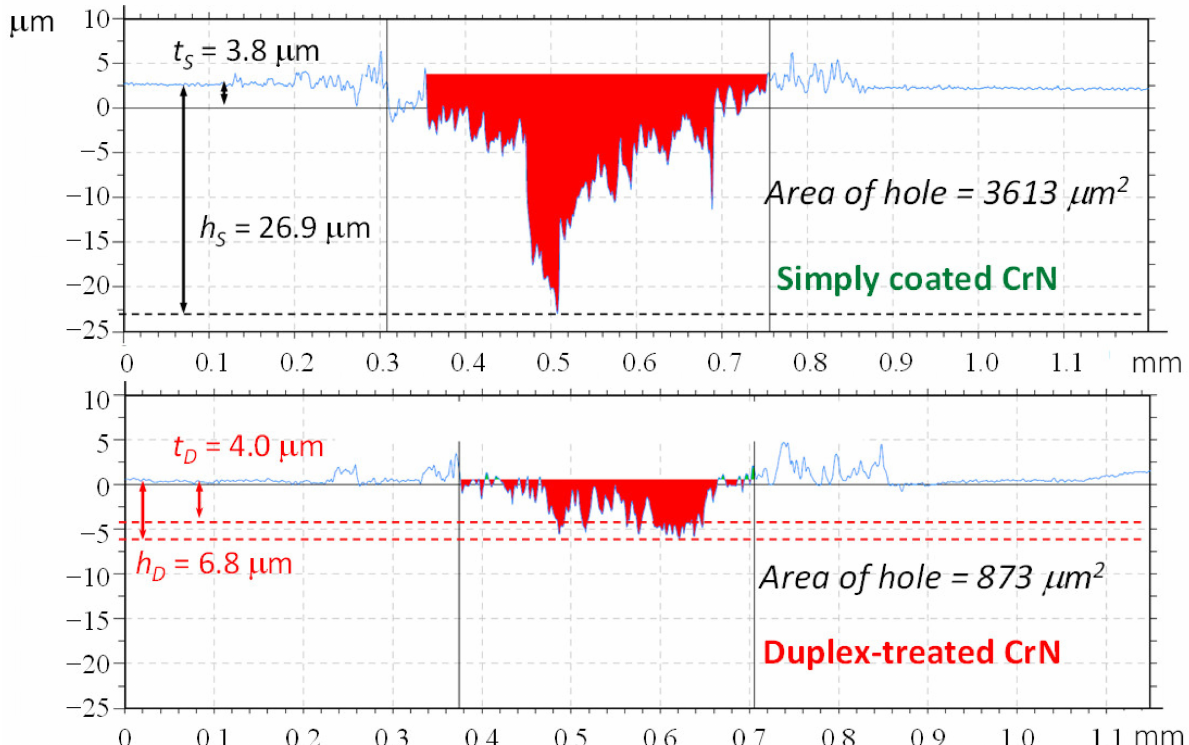
Figure 10. Worn track profiles of simply coated (S) and duplex-treated (D) samples ( t : coating thickness; h : depth of wear